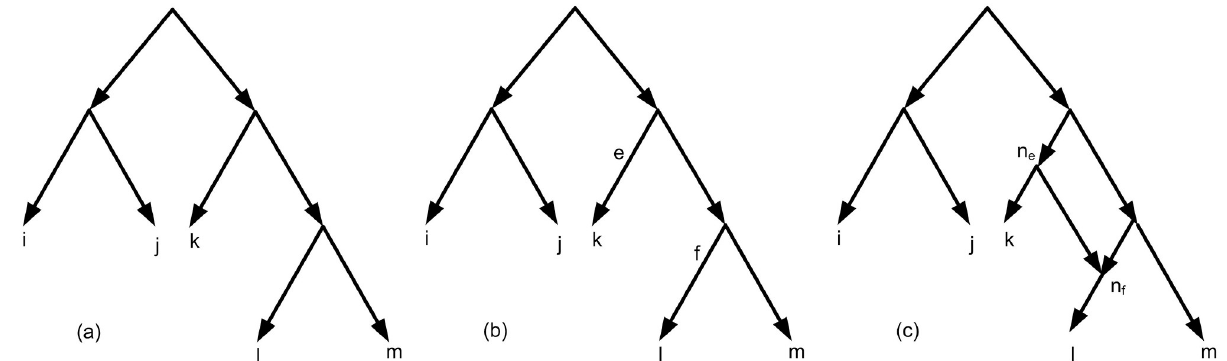
Fig 18. (a) T for τ 0 = { ij | k , ij | l , ij | m , lm | k , lm | j , lm | i , mk | i , mk | j , lk | i , lk | j } and τ = τ 0 [ { lk | m }. (b) Two edges e and f are selected to obtain a network intBin consistent with τ . (c) Final network consistent with τ .